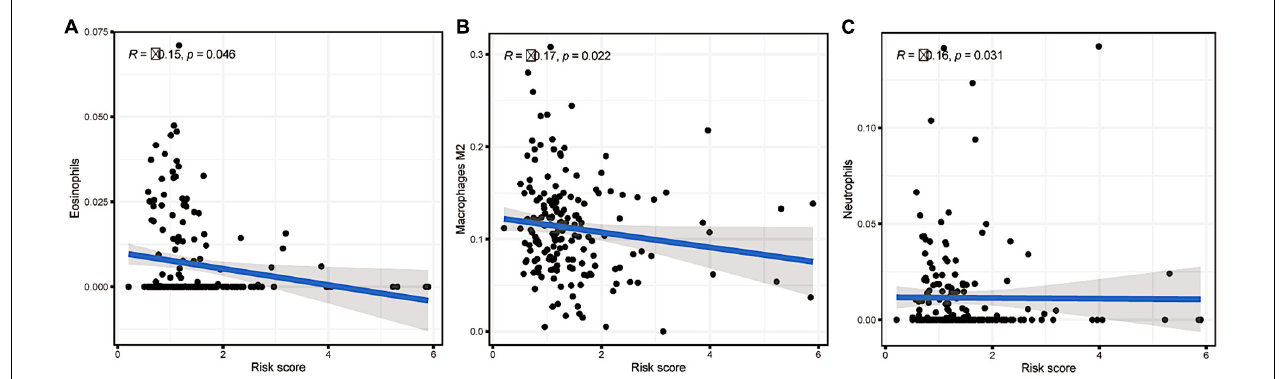
FIGURE 10 | Relationships between the risk score and infiltration abundances of three immune cell types. (A) Eosinophils ( p = 0.046), (B) M2 macrophages ( p = 0.022), and (C) neutrophils ( p = 0.031).